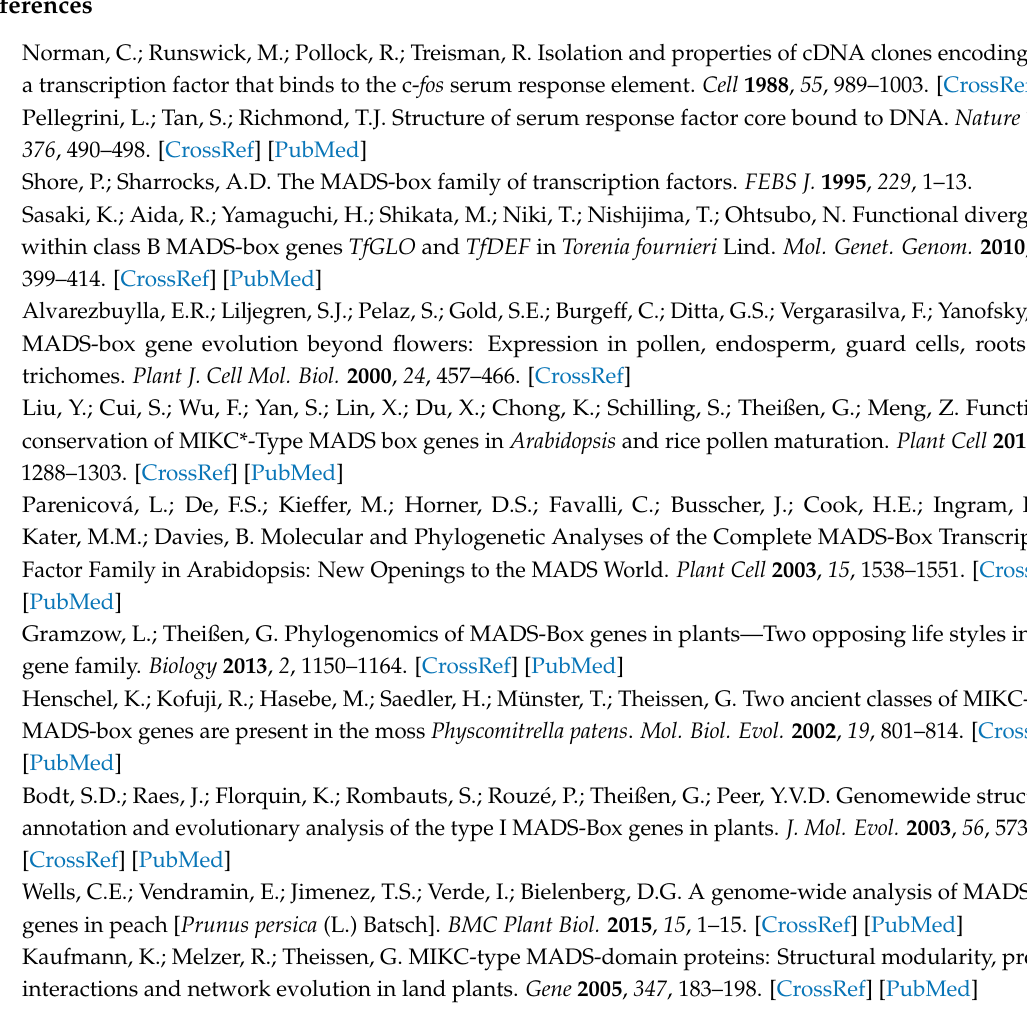
s1, Table S1: Arabidopsis MADS sequences for the phylogenetic tree, Table S2: Rice MADS sequences for the phylogenetic tree, Table S3: Primers for quantitative PCR of DcaMADSs , Table S4: Primers for subcellular localization of DcaMADSs, Table S5: The number of B and E class genes in different species, Table S6: Sequences of B and E class genes for the phylogenetic tree, Figure S1: The ORF of DcaMADS6, DcaMADS8, DcaMADS18, DcaMADS28, and DcaMADS29, Figure S2: Conserved motifs of 39 carnation MADS-box proteins identified using the MEME program. The information of Motifs 1 to 15, Figure S3: The phylogenetic tree of the 39 DcaMADS genes was generated by the neighbour-joining (NJ) algorithm using Molecular Evolutionary Genetics Analysis (MEGA version 6.0) software. The subgroups are marked in different colors. (a) Phylogenetic tree of D. caryophyllus and Rice type II proteins. (b) Phylogenetic tree of Rice and D. caryophyllus type I proteins, Figure S4: The